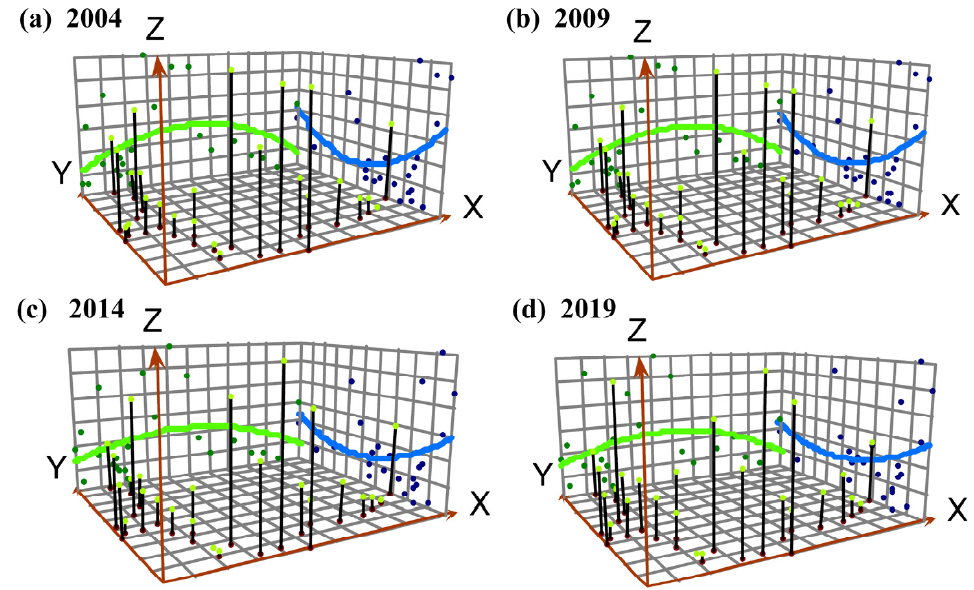
Figure 5. Spatial change trend in ecological security in 25 border counties in Yunnan Province, China